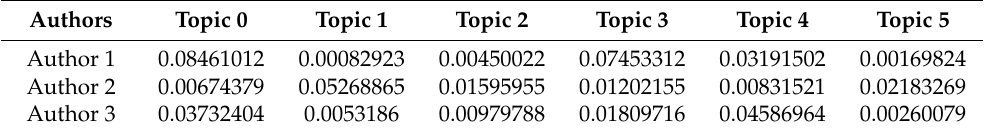
Table 8. Topics’ distribution for authors.